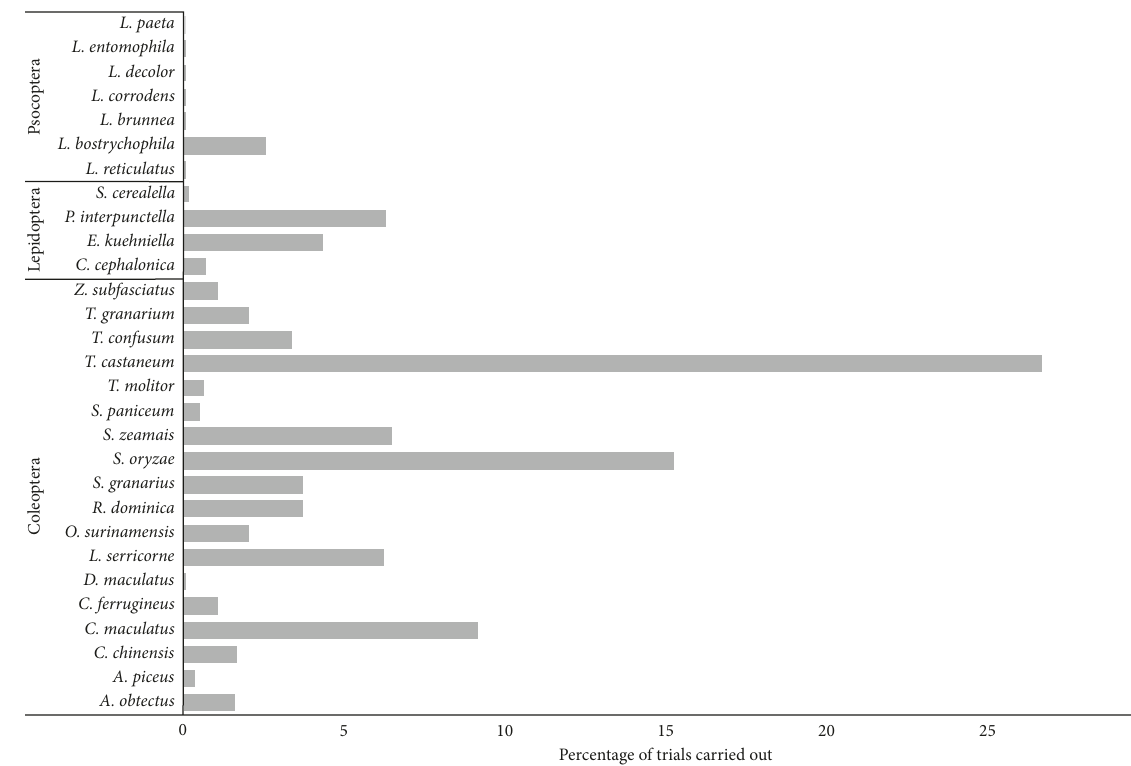
Figure 4: Percentage of trials carried out for every insect species accounted in the reviewed literature.